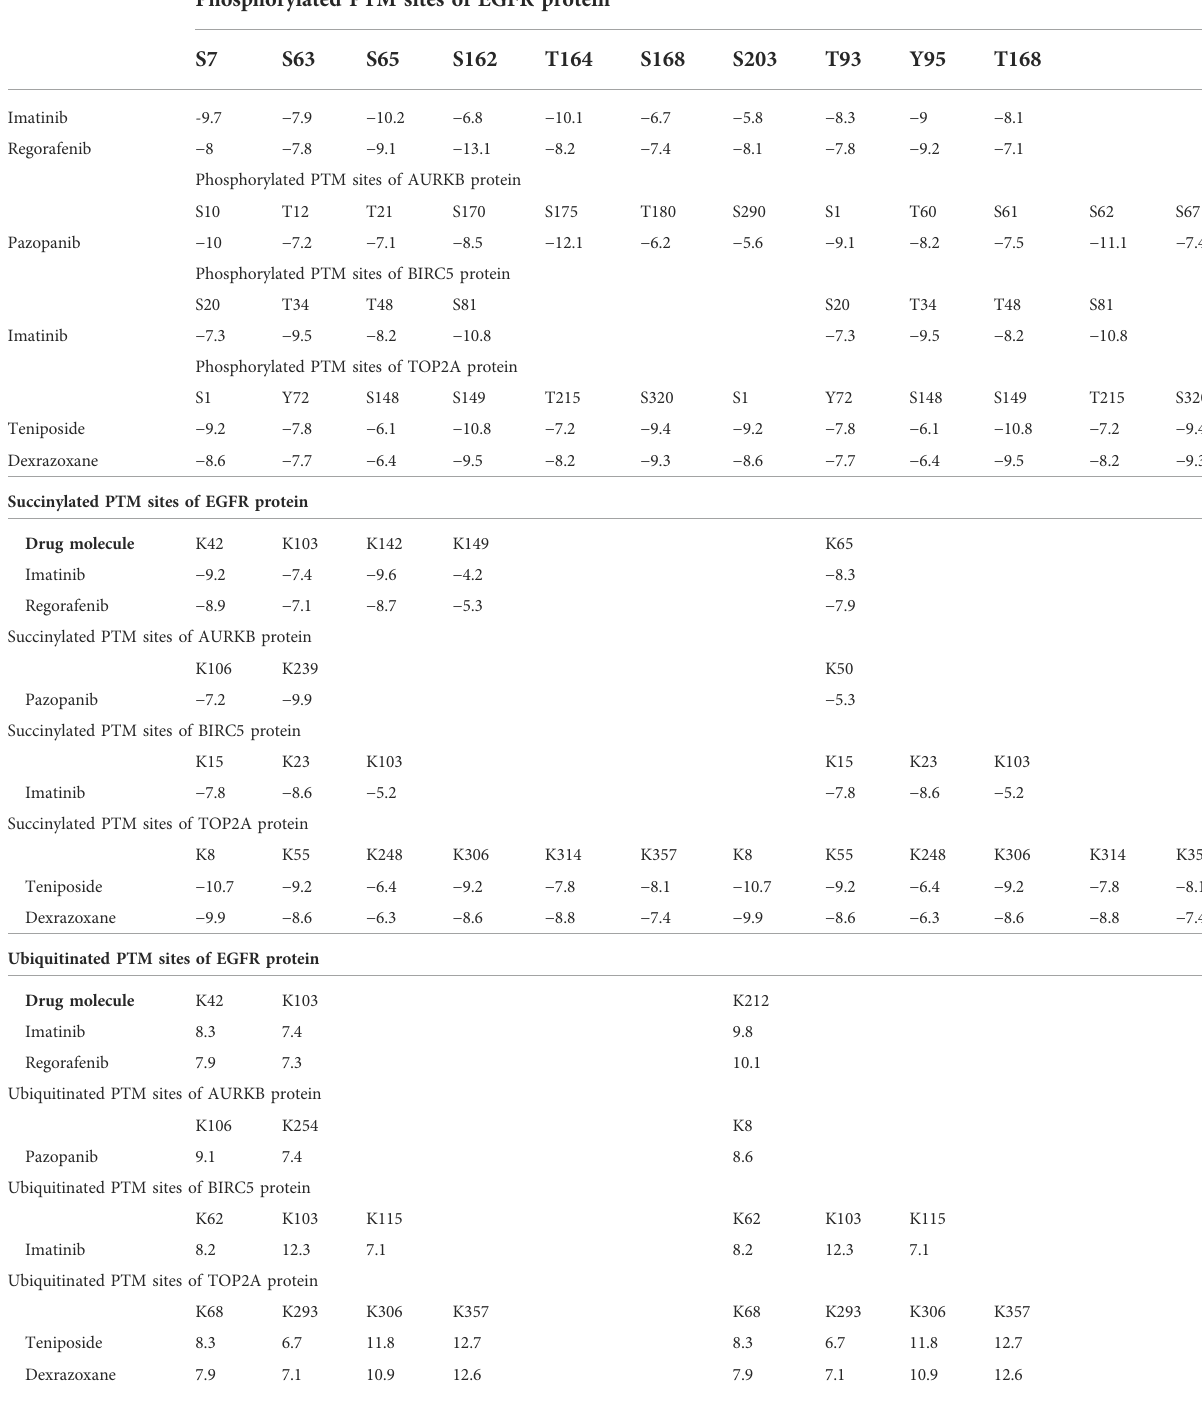
TABLE 4 Docking scores between the proposed drug molecules and the PTM sites of key proteins. Drug molecule Chain A Chain